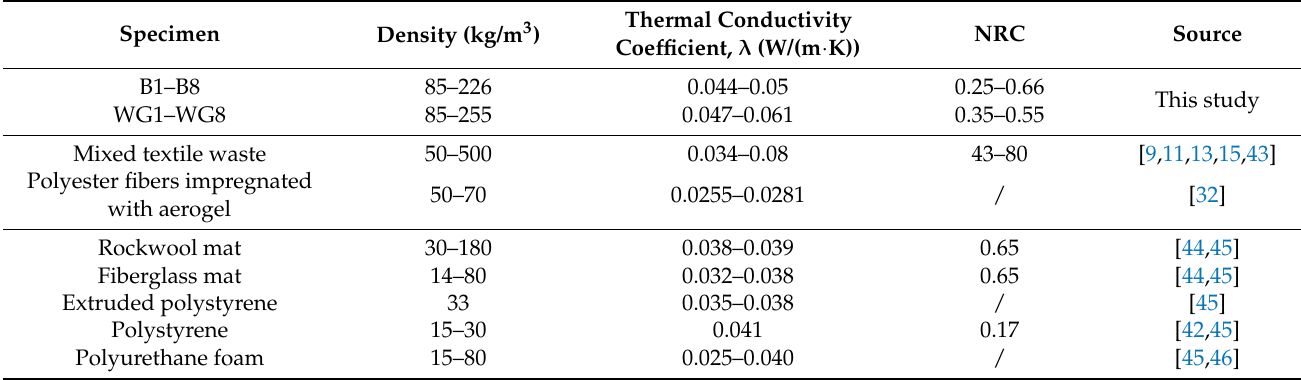
Table 5. Summary of density, thermal insulation coefficient λ and noise reduction coefficient NRC for the developed insulation boards and various conventional insulation